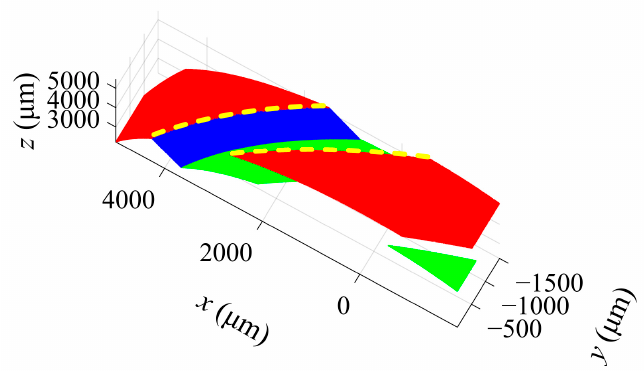
Figure 8. Point cloud segmentation of the swirl slot.